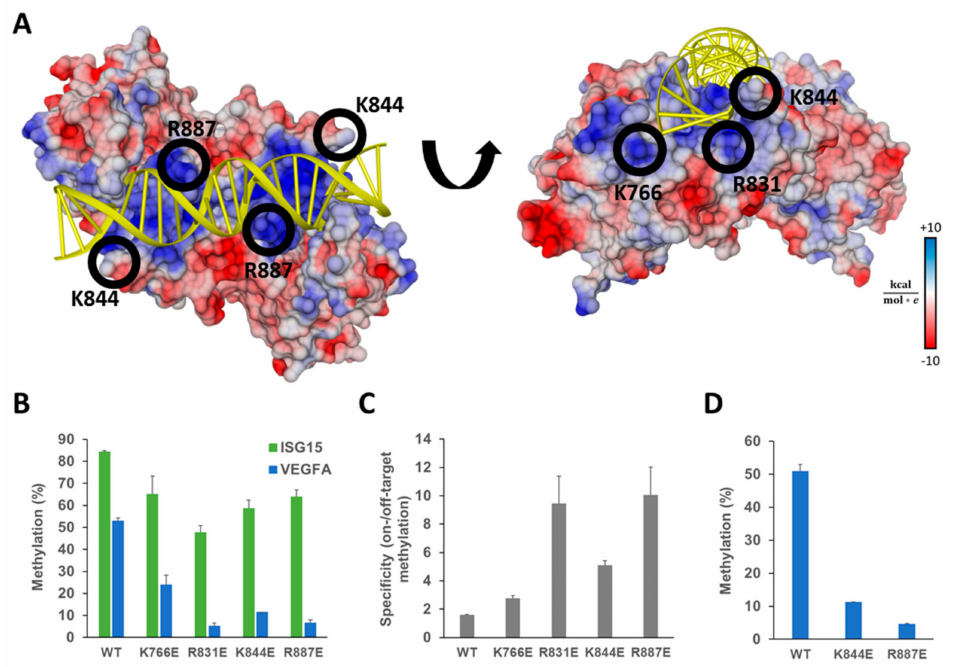
Figure 3. Ab-3A3L containing DNMT3A mutants with reduced DNA binding shows lower o ff -target methylation but retains most of the on-target activity. ( A ) Crystal structure of the DNMT3A-DNA complex (pdb 5YX2, [36]) showing the DNA (yellow) bound to the central dimeric DNMT3A catalytic domain colored according to the surface charge (blue positive, red negative). Positively charged residues on the protein surface (blue patches) interact with the negatively charged DNA phosphodiester backbone. Amino acids K766, R831, K844, and R887 were selected for mutagenesis and replaced by glutamic acid to reduce the strength of the protein–DNA interaction. ( B ) DNA methylation of the target ( ISG15 ) and o ff -target ( VEGFA ) regions analyzed by targeted bis-seq in HEK293 cells using the dCS system with ISG15 sgRNA and DNMT3A wild type and mutants in Ab-3A3L. Results for the wild type DNMT3A are taken from Figure 2D and shown for comparison. Data present the mean of two independent experiments and error bars show the standard deviation. p -Values for comparison of the o ff -target activity of the mutants with wild type were 9.36 × 10 − 3 (K766E), 4.19 × 10 − 4 (R831E), 2.69 × 10 − 4 (K844E), and 5.05 × 10 − 4 (R887E) (one-sided t-test assuming unequal variance based on the experimental repetitions). ( C ) The specificity of the EpiEditors calculated as a ratio of the on- versus o ff -target DNA methylation based on the data of (B). ( D ) O ff -target methylation analyzed at the VEGFA CGI for Ab-3A3L containing wild type and mutated DNMT3A co-transfected with dCS and the scrambled sgRNA coding vector. See also Figure